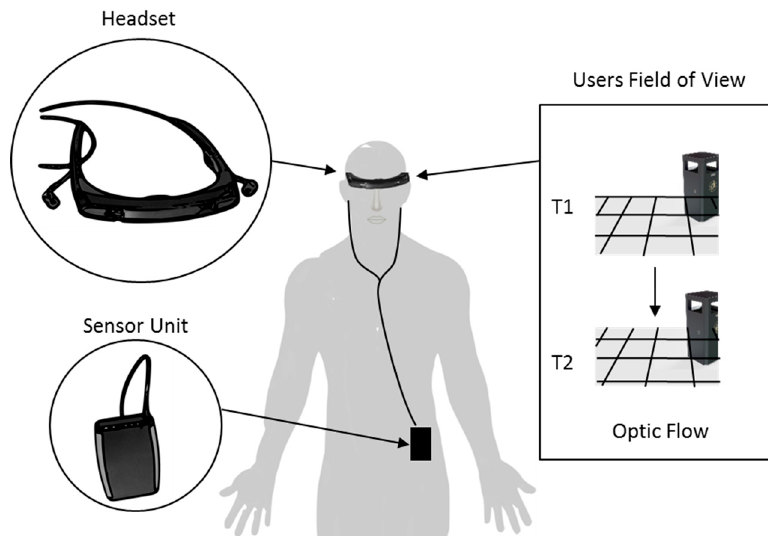
Figure 8. Illustration of the Visual ‐ auditory walker, developed by Espay et al. The system was composed of a sensor unit and a head ‐ mounted micro ‐ display with earphones. The sensor unit was attached to the user’s clothing and the headset worn around the eyes. The system provided continuous optical flow visual cueing. During cueing, a virtual checkerboard ‐ tiled floor is overlayed on top of the user’s field of view (T1) and continually moves forward on the screen at a rate equal to the user’s real ‐ time gait speed (T2).